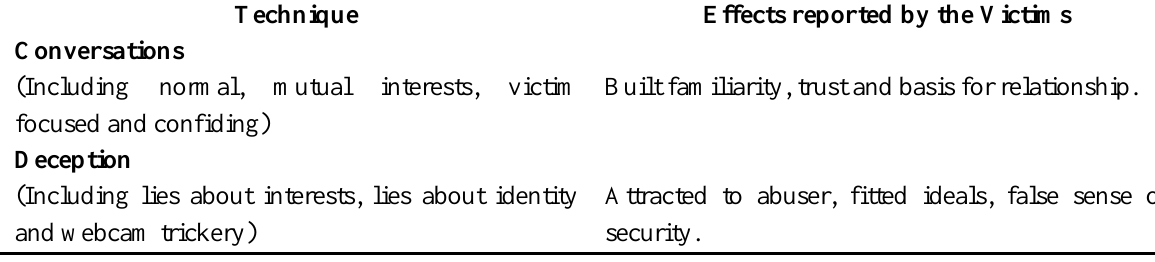
Table 2. Subthemes of offender manipulation techniques and effect on